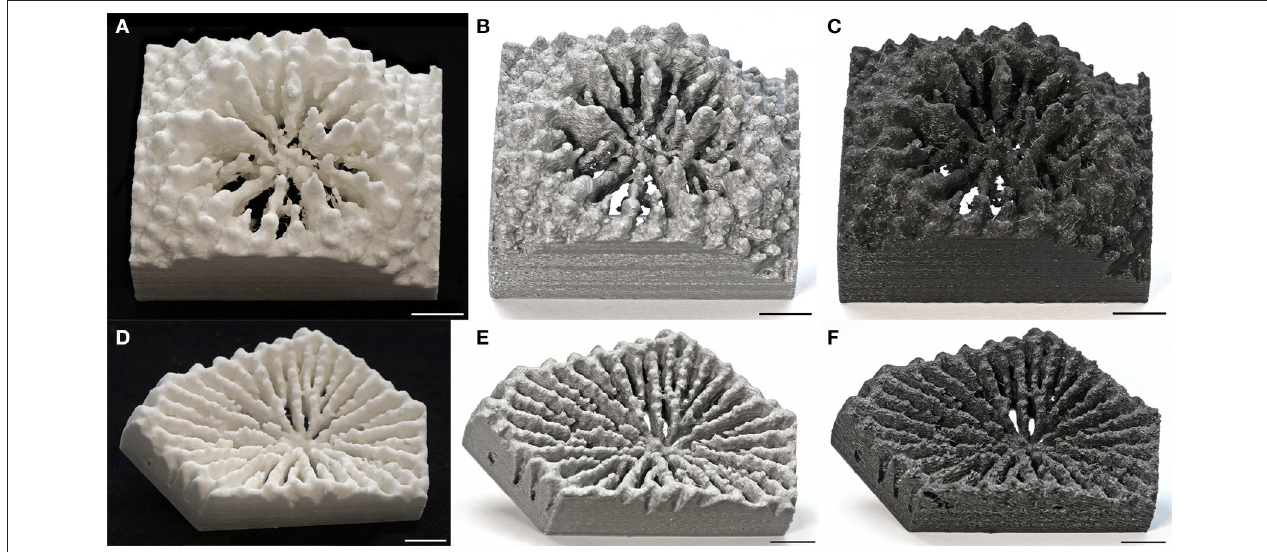
FIGURE 7 | Multi-material 3D printing of Echinopora sp. and Siderastrea savignyana skeletal corallites from MicroCT scanning imaging. (A) White PLA print of Echinopora sp. corallite. (B) Silver PLA print of Echinopora sp. corallite. (C) Black PLA print of Echinopora sp. corallite. (D) White PLA print of S. savignyana corallite